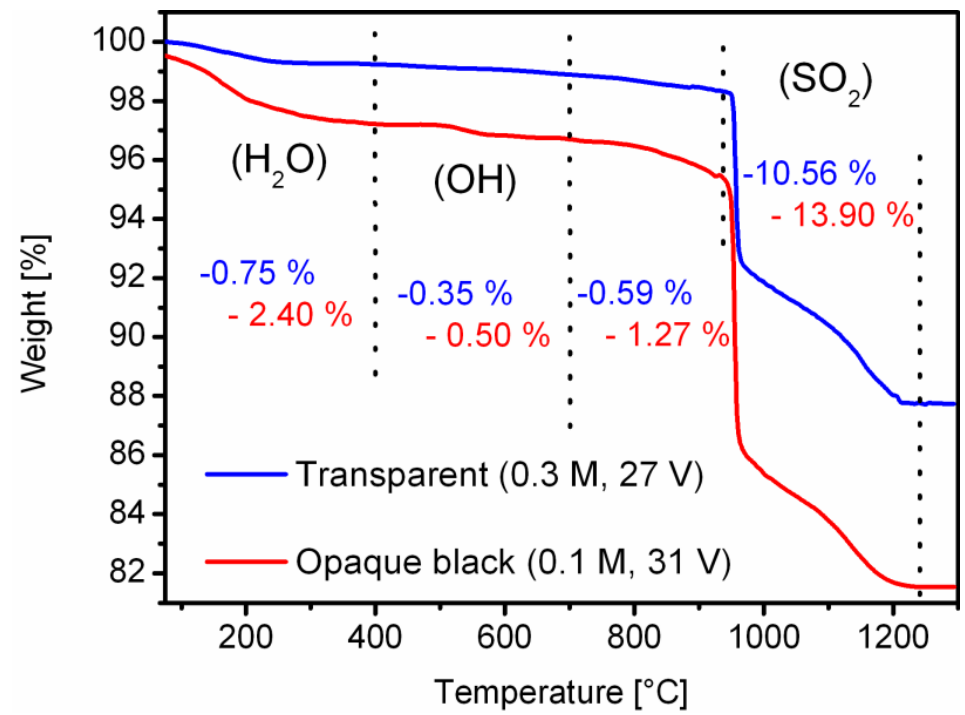
Figure 5. A comparative thermogravimetric analysis (TGA) of transparent PAA and opaque black b-PAA samples obtained from sulfuric acid electrolytes under moderate applied voltages.